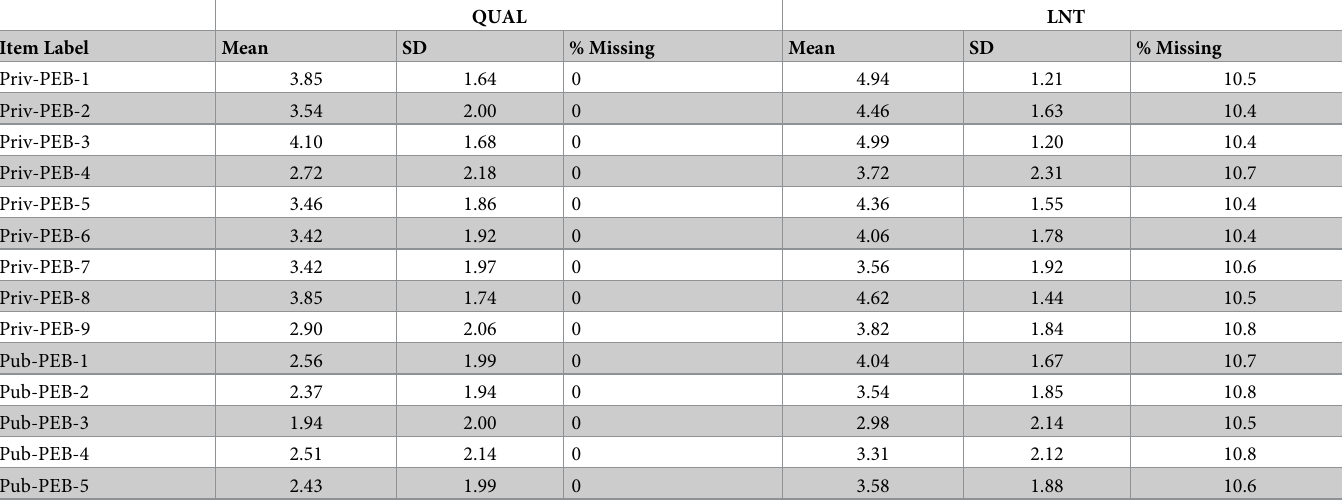
Table 3. Descriptive statistics for QUAL and LNT for PEB items.